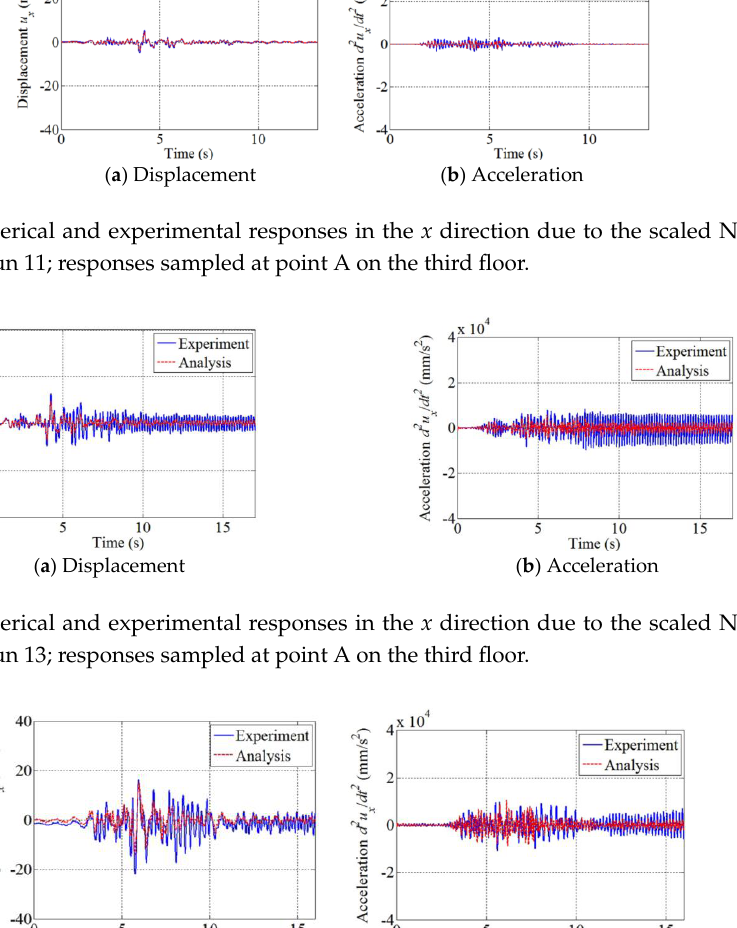
Figure 26. Numerical and experimental responses in the x direction due to the scaled Northridge earthquake of Run 17; responses sampled at point A on the third floor.